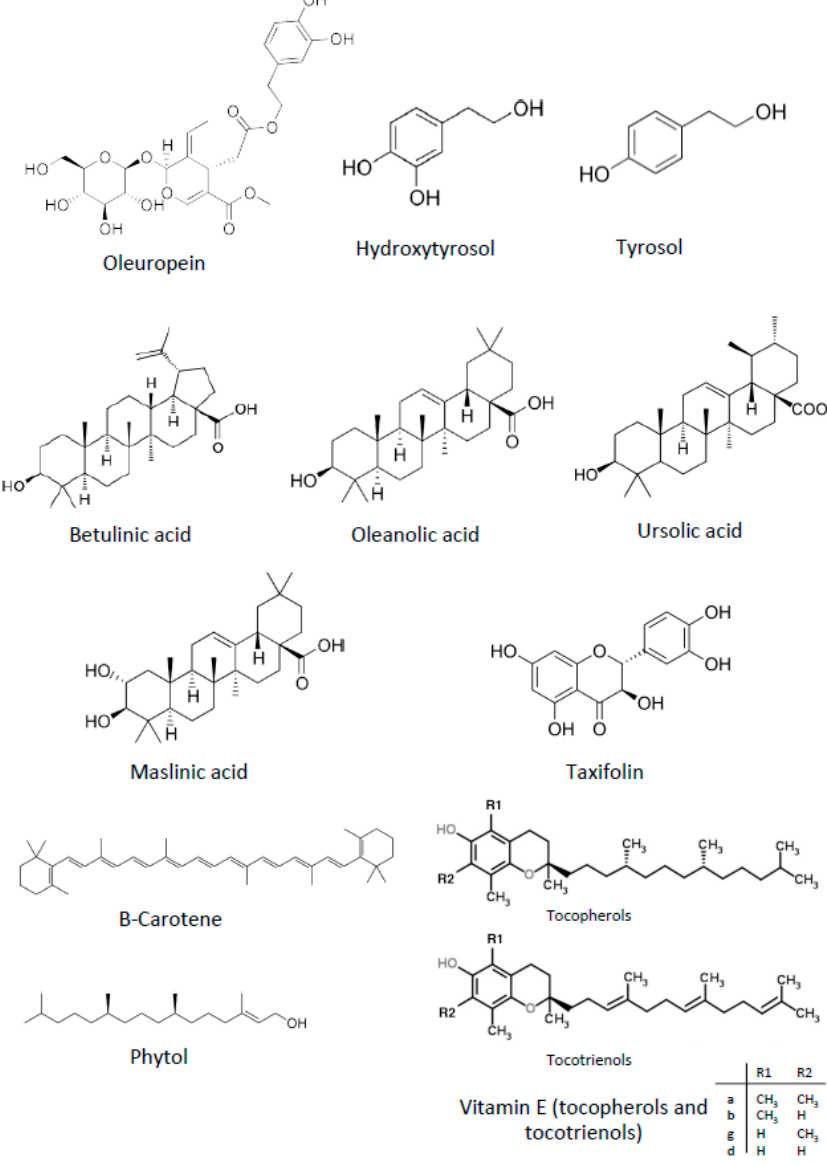
Figure 2. Chemical structures of antiangiogenic compounds present in extra virgin olive oil.